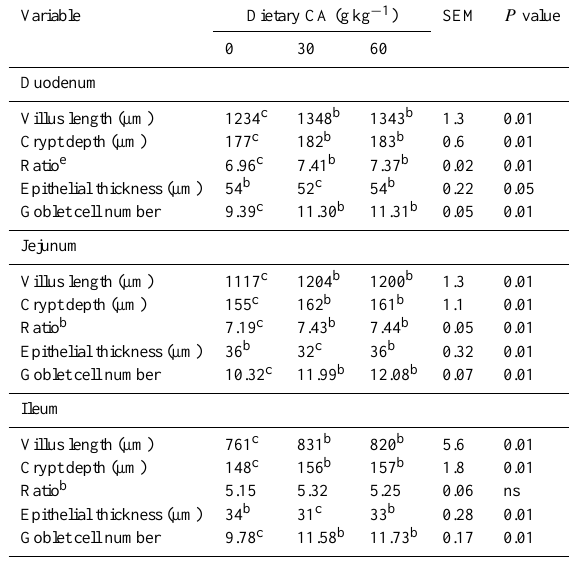
a Each value represents the mean of 10 observations (five replicates × two birds per replicate). b − c Mean values within a column with no common superscript differ significantly from each other ( P <0.05); ns, not significant. e Ratio of villus length to crypt